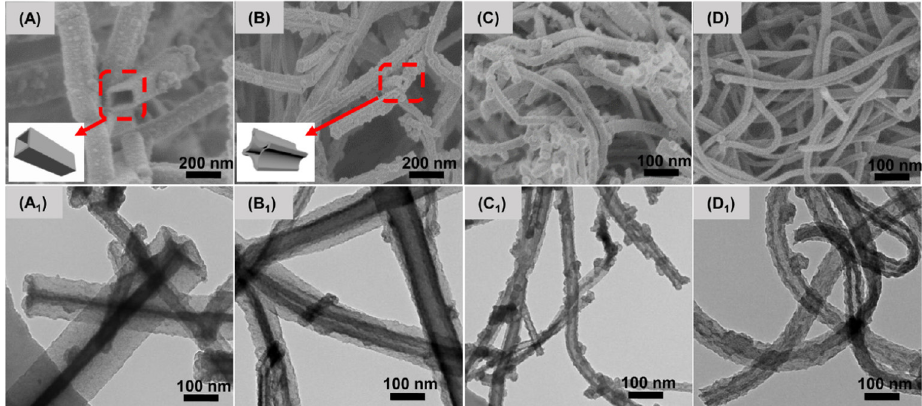
Figure 5. Characterization of the RPPy and CPPy before and after being carbonized at 1600 °C. SEM images of ( A ) RPPy, ( B ) RPPy1600, ( C ) CPPy, and ( D ) CPPy1600; TEM images of ( A1 ) RPPy, ( B1 ) RPPy1600, ( C1 ) CPPy, and ( D1 ) CPPy1600 [39]. Copyright 2019 Elsevier.